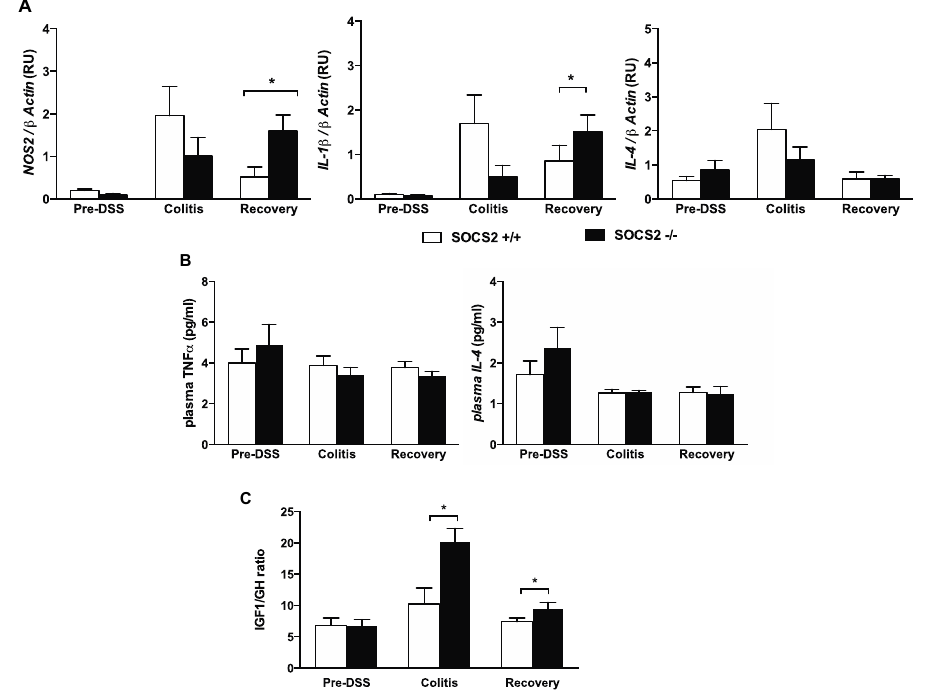
Figure 2. Growth hormone and inflammatory activity during colitis and recovery. ( A ) Gene expressions of pro-inflammatory (NOS2 and IL-1 β ) and anti-inflammatory cytokines (IL-4) in colonic tissue prior, during DSS-induced colitis and at recovery in wild-type (SOCS2 +/+ ) and SOCS-knockout (SOCS2 − / − ) mice. Gene expressions were measured using the relative standard method and normalised to expression of the β -actin gene. Data are shown in relative unit (RU). ( B ) Plasma cytokine levels of TNF α and plasma IL-4 of in both mice groups. ( C ) Growth hormone (GH) sensitivity index measured as the ratio of plasma IGF-1 / GH in both mice groups during the three time points of the model. * Student’s t -test p -value < 0.05; n = 6 per mice group for the gene expression study and for plasma analysis n = 10 per group .